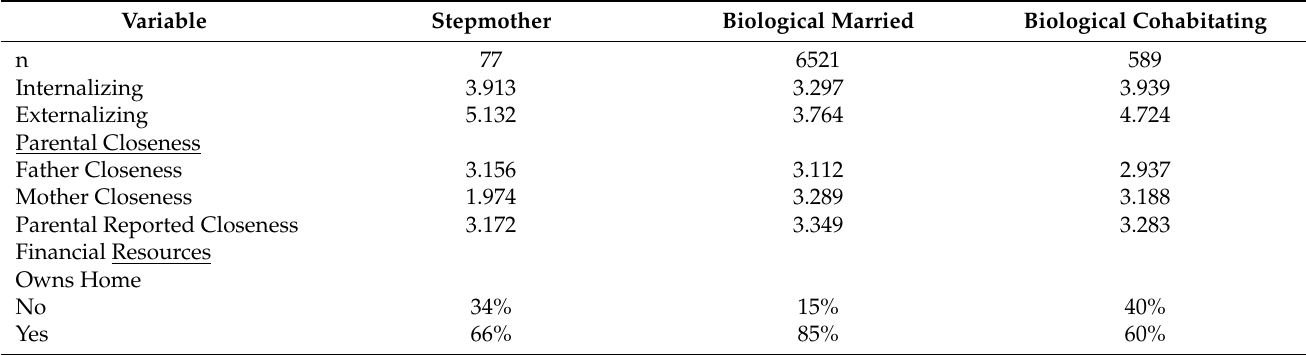
Table 2. Means/Proportions by Family